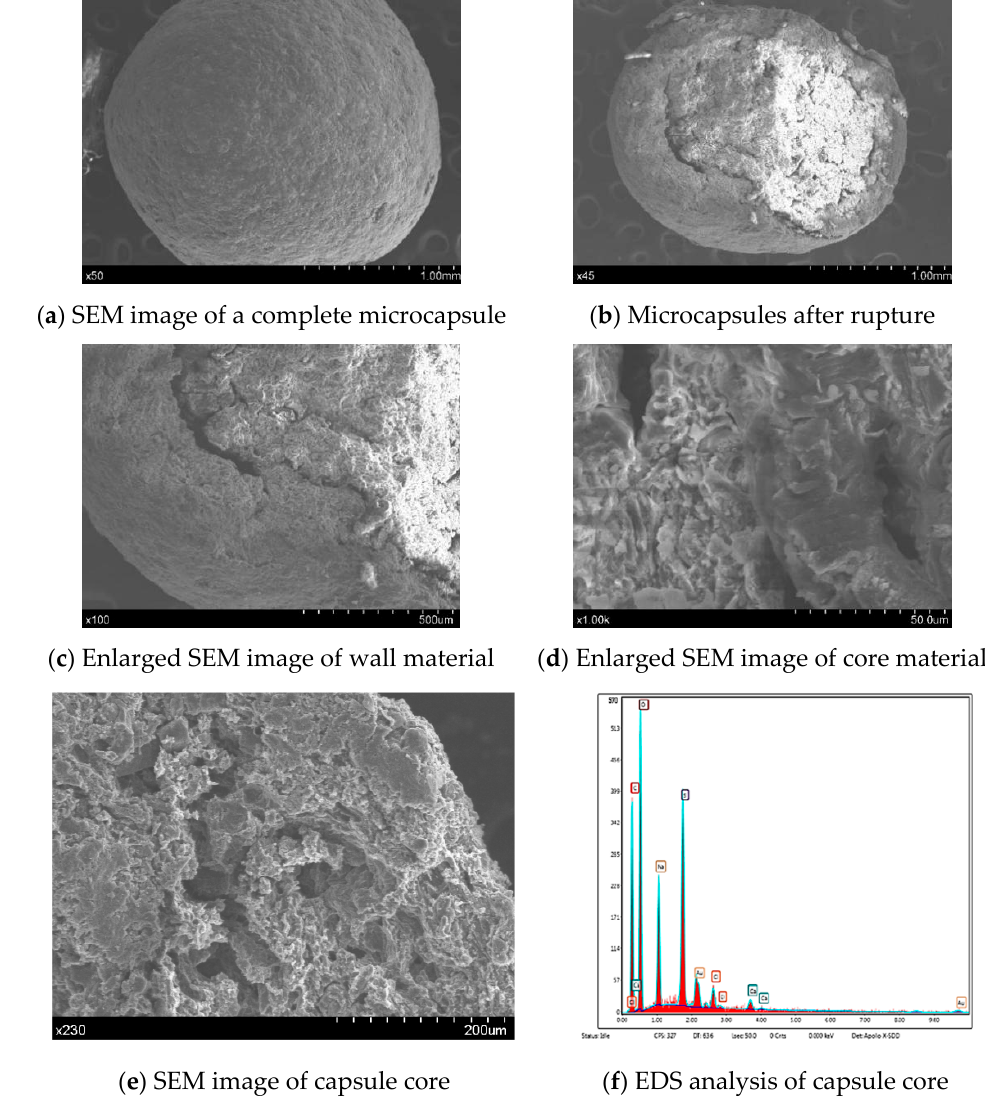
Figure 3. ( a – f ) SEM and EDS analysis of microcapsules.